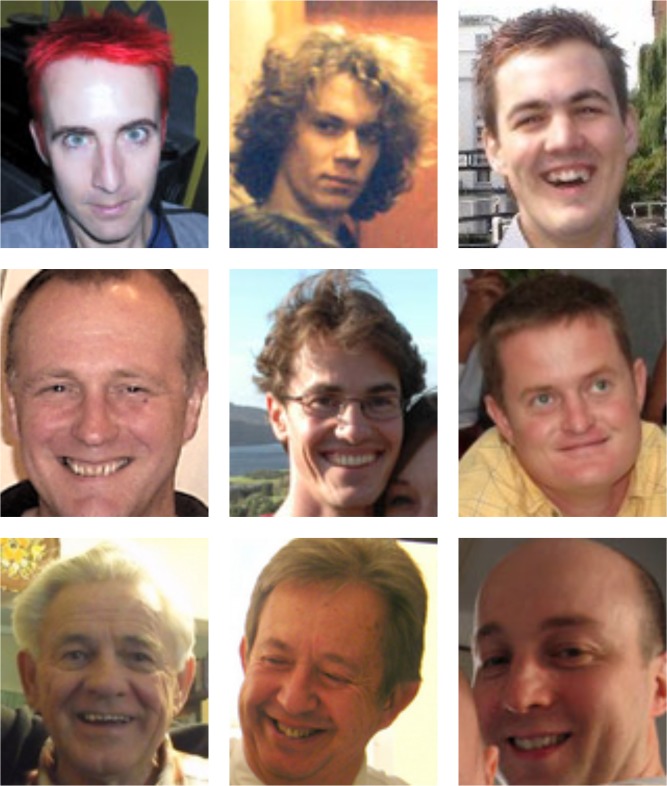
A second challenge grid.One of these faces is also present in Fig. 4. Even with a single grid, it is difficult to determine which face is repeated simply by trying to memorise Fig. 4. Side-by-side matching of unfamiliar faces is also highly error prone (Jenkins & Burton, 2008; Jenkins & Burton, 2011).